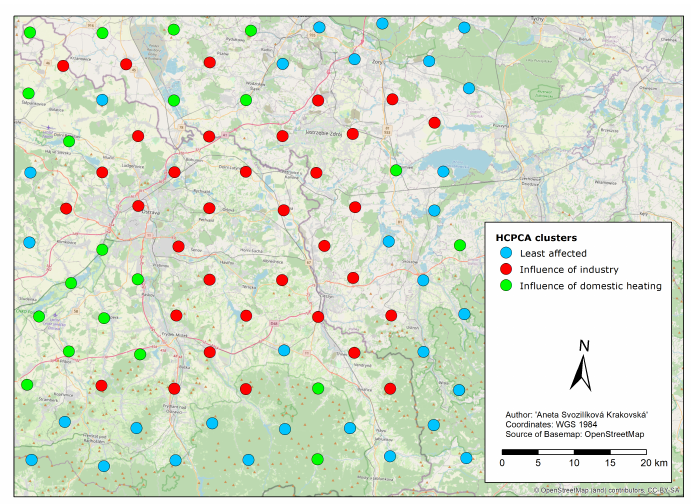
Figure 8. The result of hierarchical clustering on three components.